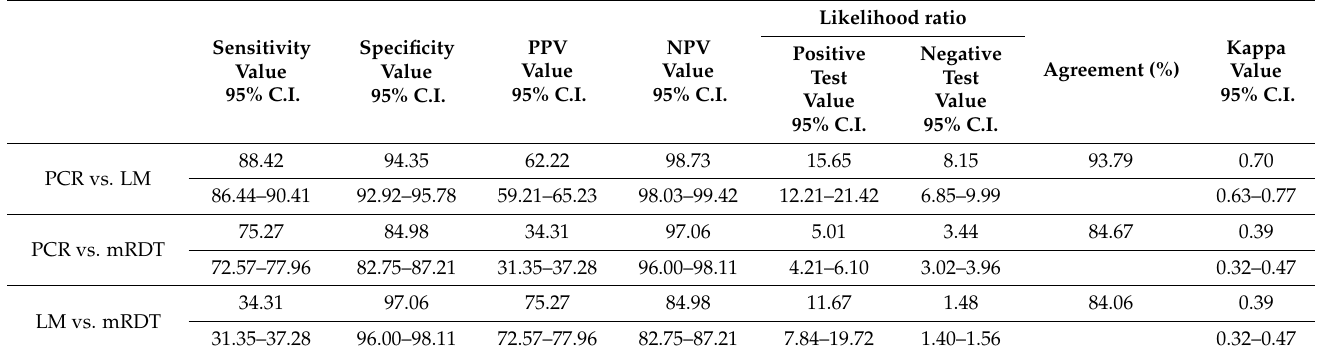
Table 2. Performance comparison between mRDT, LM and PCR in the study